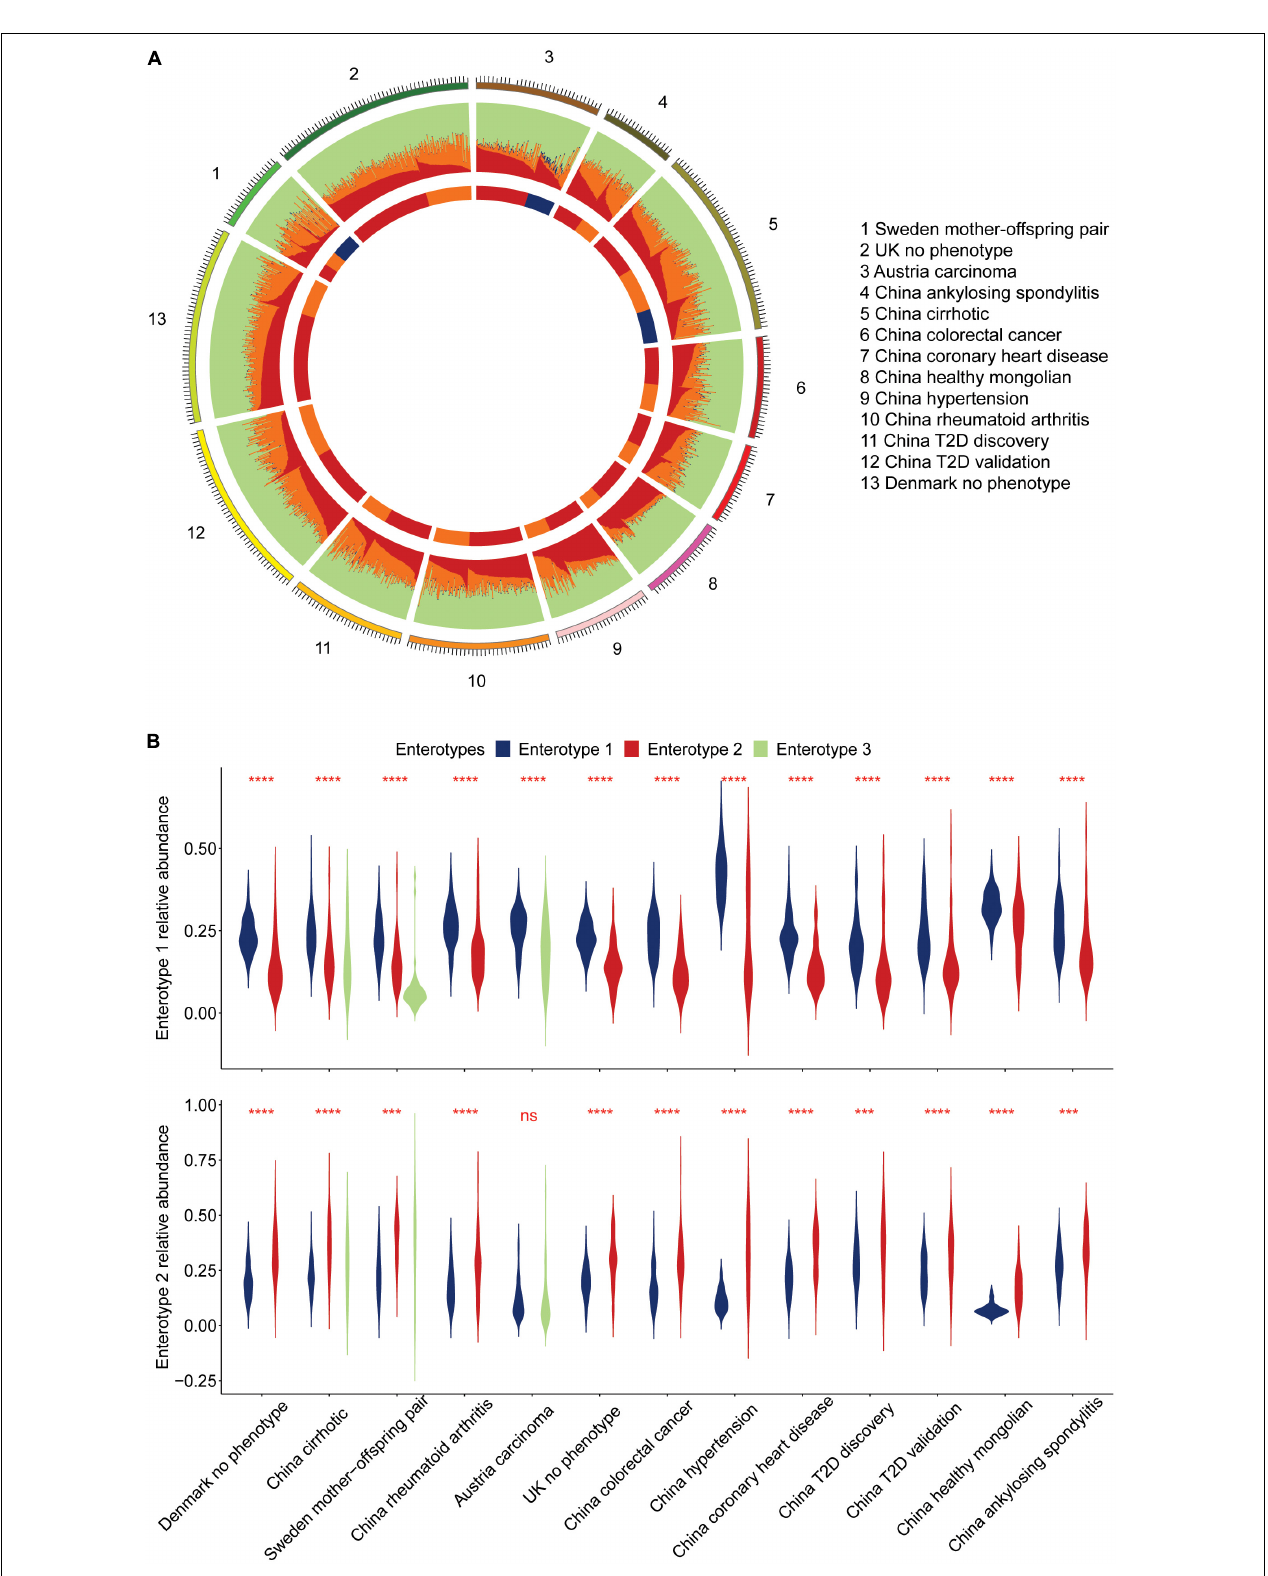
FIGURE 5 | Approximate composition of the human viral community. (A) We classified the human viral community into four categories: enterotypes 1, 2, 3 specific viruses, and the others, represented by different colors. (B) Display of the leading components in the human gut virome for individuals of enterotype 1 and 2.